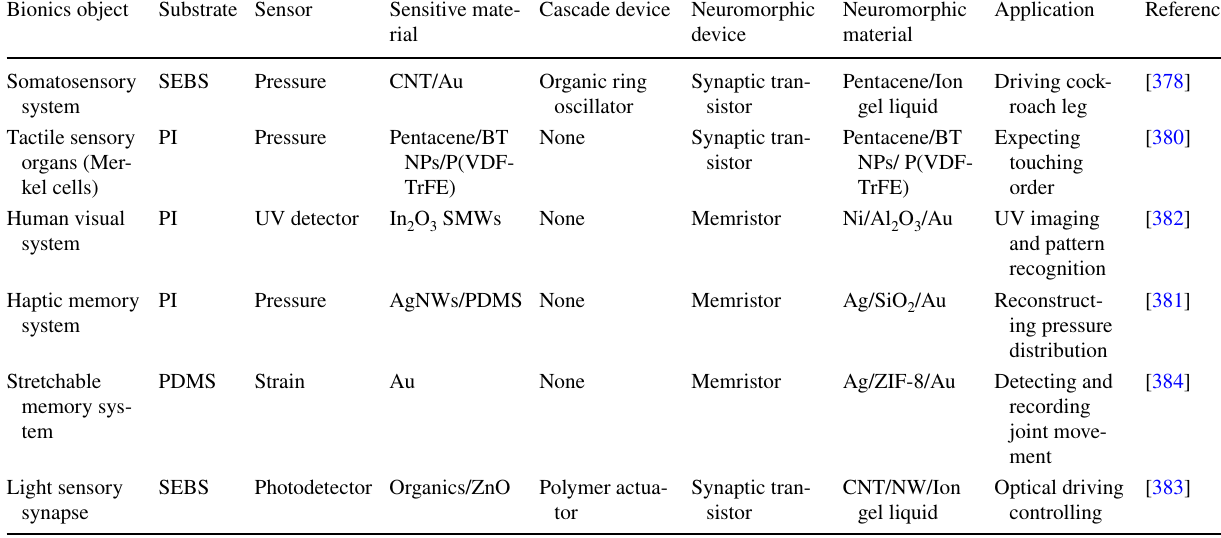
Table 6 Typical biomimetic systems Bionics